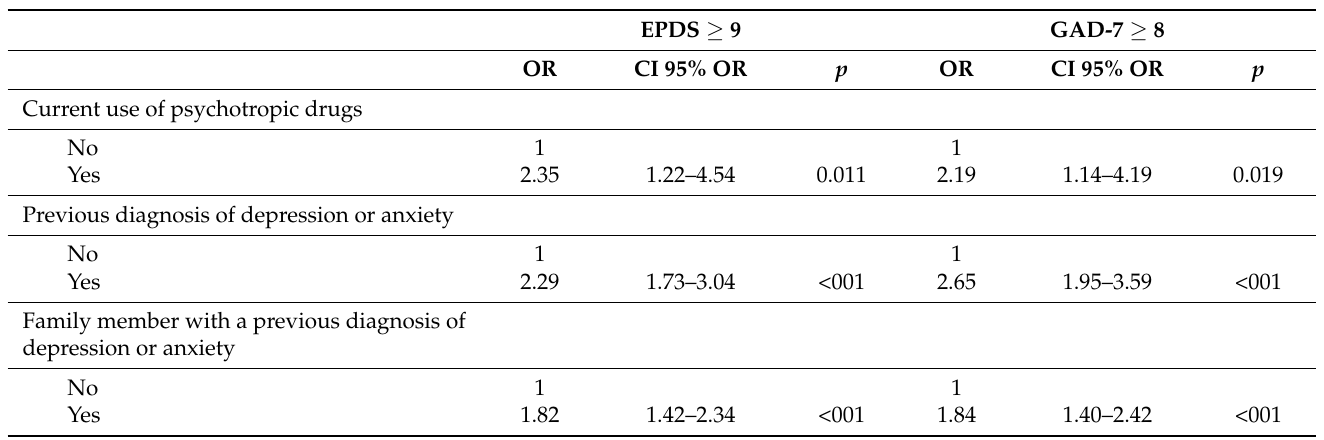
Table 6. Association of clinic variables and risk of depression (EPDS score ≥ 9) and anxiety (GAD-7 score ≥ 8): results of multiple logistic regression